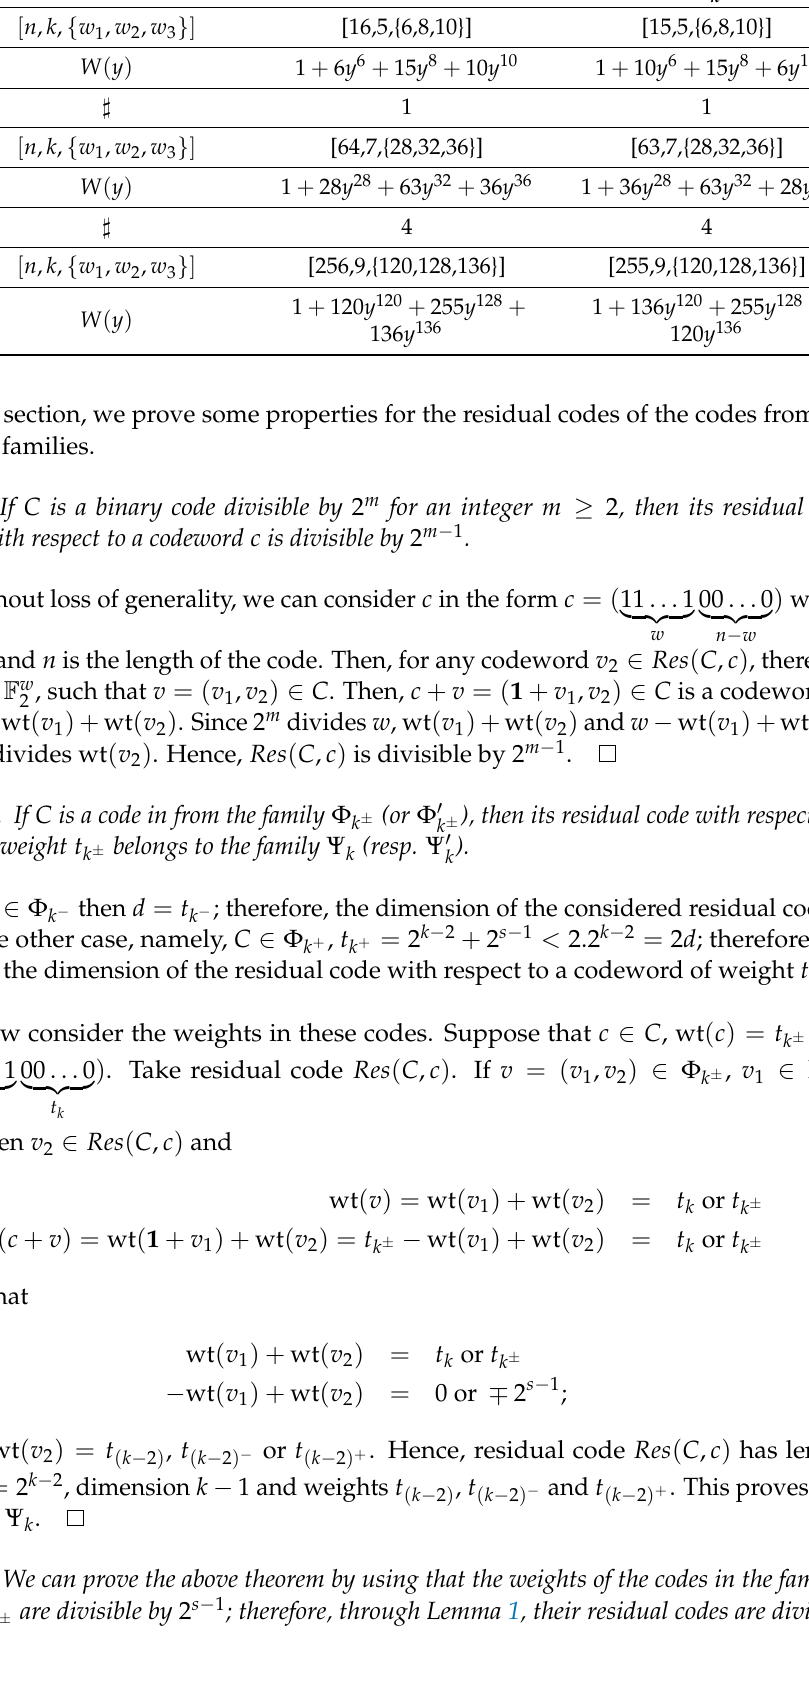
Table 2. Families Ψ S